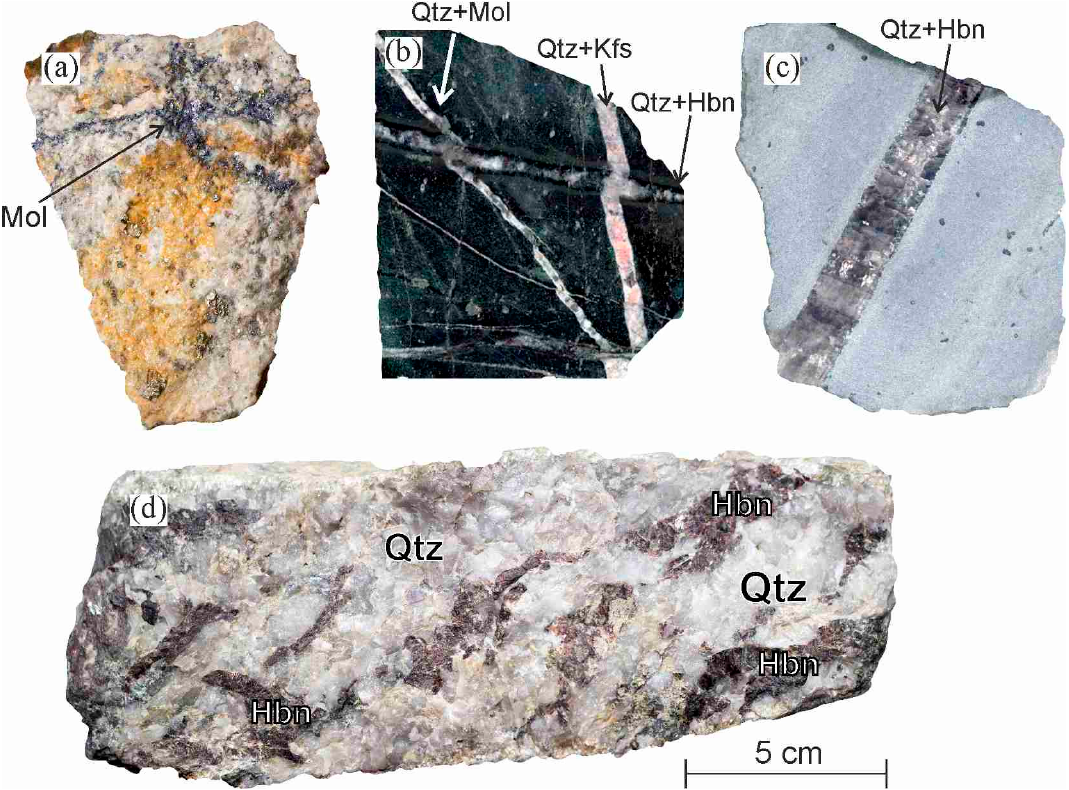
Figure 2. Photos of typical ore-samples from the Dzhida ore-field. ( a ) Molybdenitic vein cutting through the Pervomaika granite (sample P-15-2); ( b ) quartz-hubnerite vein cutting through the quartz–molybdenite vein. All the veins cut through the crystalline schist (the Inkur deposit) (sample 105-78); ( c ) quartz–hubnerite vein cutting through the dike of alkaline syenite (the Inkur deposit) (sample 110); ( d ) hubnerite grains within quartz (the Kholtoson) (sample Dzh-1). Mol—molybdenite, Hbn—hubnerite, Otz—quartz, Kfs—K-feldspar.